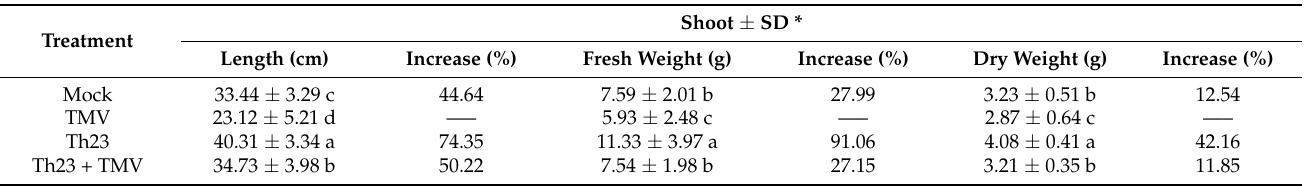
Table 2. The effect of different treatments of Th23 and TMV inoculation on the length, fresh, and dry weights of the shoot system in tomato plants.